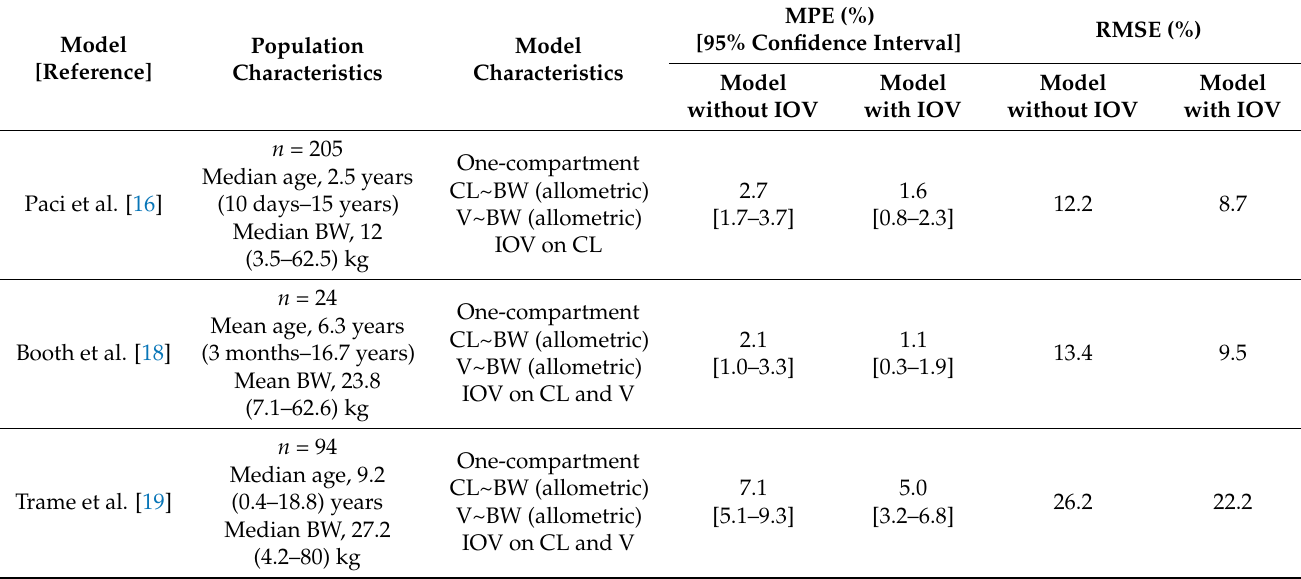
Table 2. Main characteristics of the selected models and predictive performance in the entire dataset ( n = 178 patients, 491 measured concentrations).